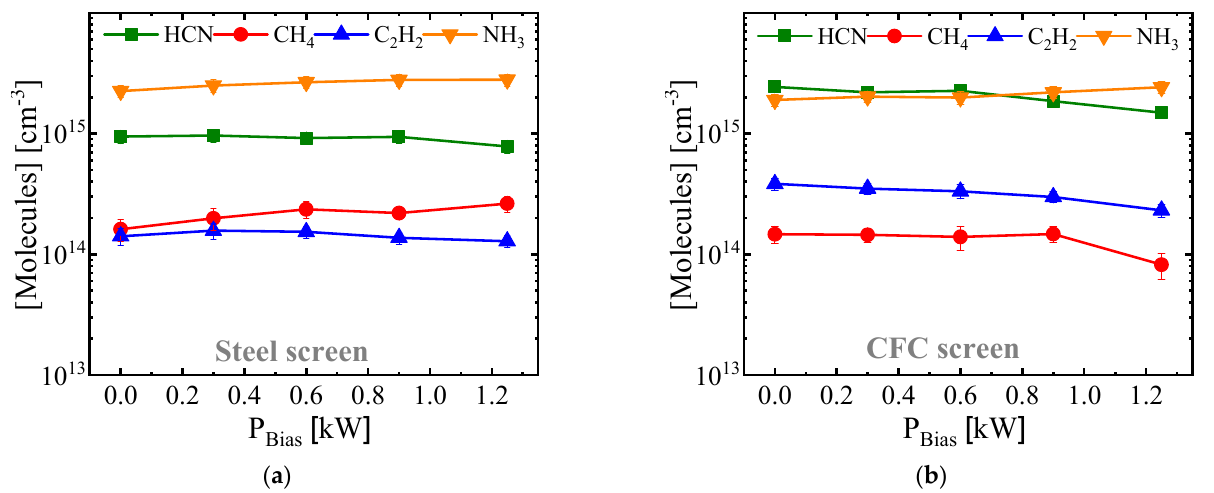
Figure 8. Concentrations of CH 4 , NH 3 , HCN, and C 2 H 2 measured as functions of the bias plasma power during ASPNC treatment using a steel AS ( Φ CH4 = 4 slh) ( a ) and a CFC-AS ( b ) at H 2 :N 2 = 1:1, T = 460 °C, Φ Total = 80 slh, and p = 3 mbar.